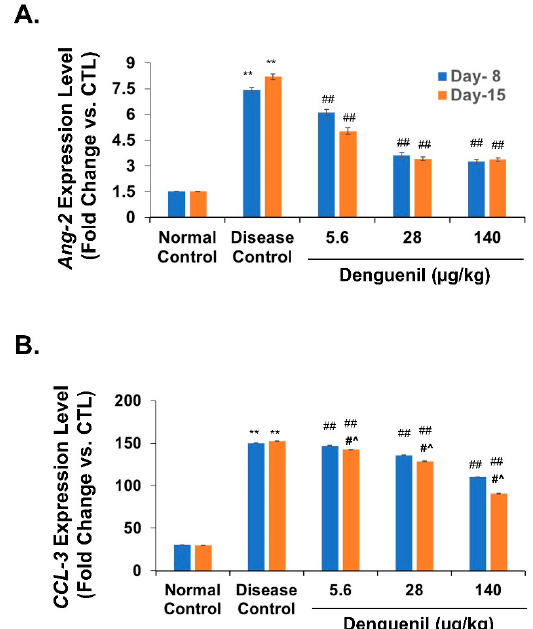
Figure 6. Denguenil treatment normalizes expression of Ang2 and chemokine CCL3 . Virus-induced increases in ( A ) Ang-2 expression and ( B ) CCL3 levels were attenuated upon Denguenil treatment in a dose-dependent manner. n = 24, data are presented as means ± SEM. **, ##, #ˆ p < 0.001. ** Represents significant compared to Normal Control; ##, Represents significant compared to their respective Disease Controls; #ˆ Represents significant di ff erence between the two time points.